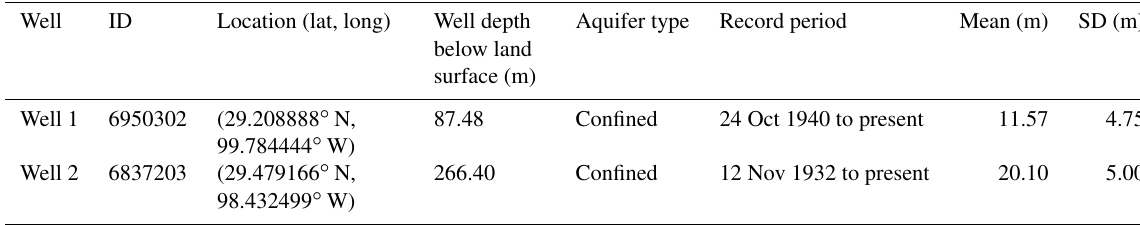
Table 1. Statistics and geophysical properties of studied wells in Texas, USA.